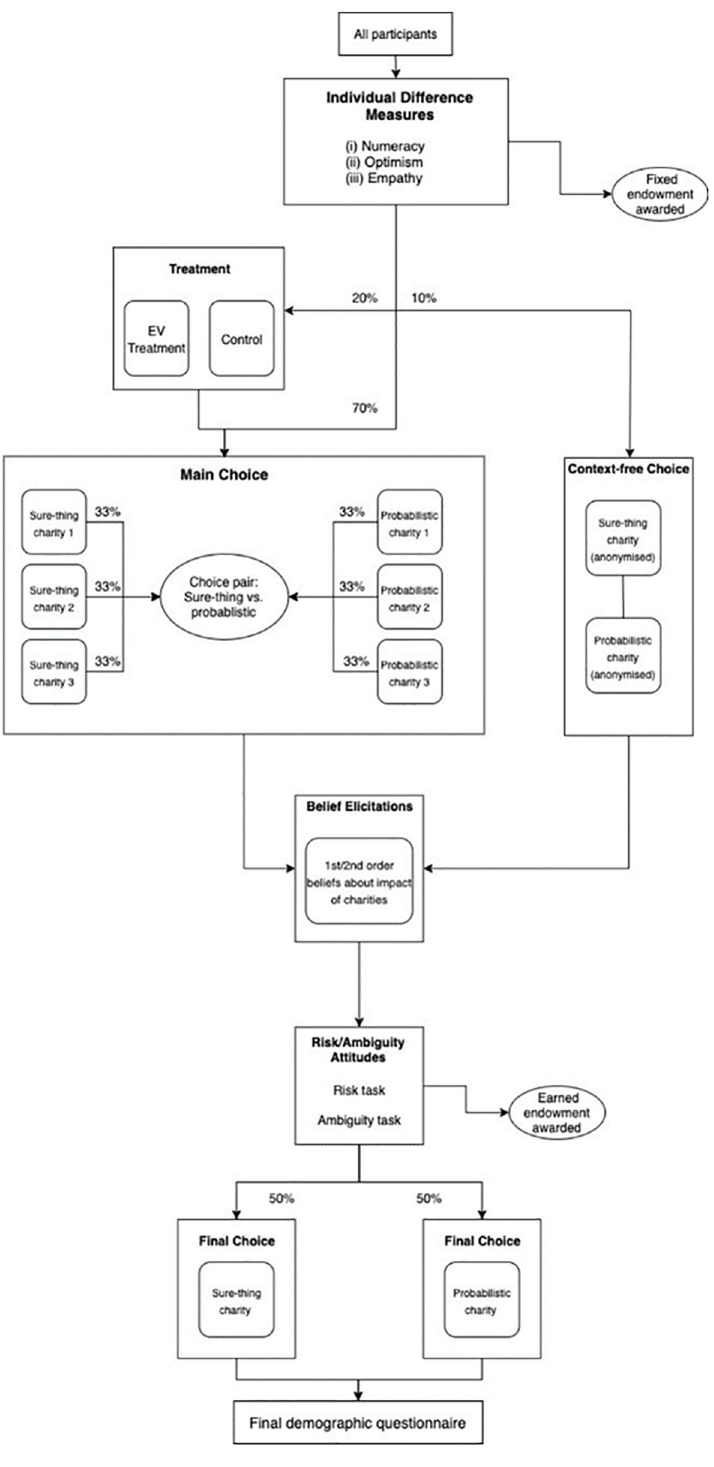
Fig 1. Experimental